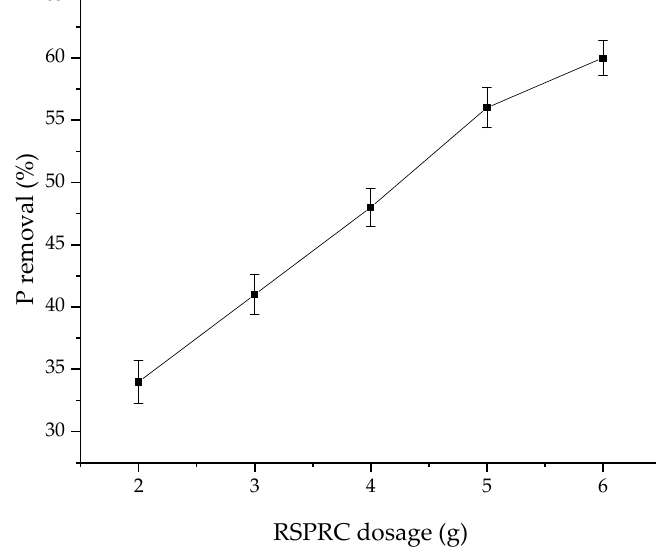
Figure 6. Effect of RSPRC dosage on phosphorus removal efficiency.